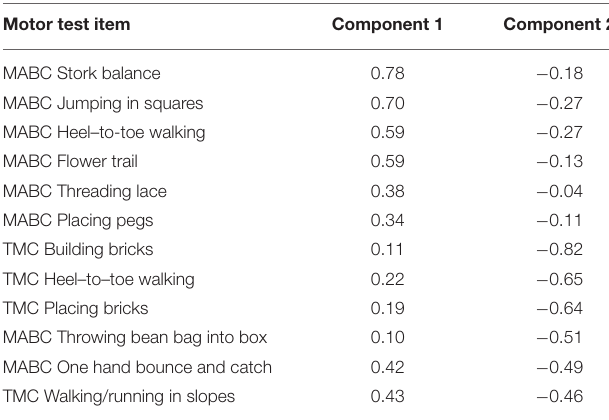
TABLE 5 | Variable weightings for the first 2 principal